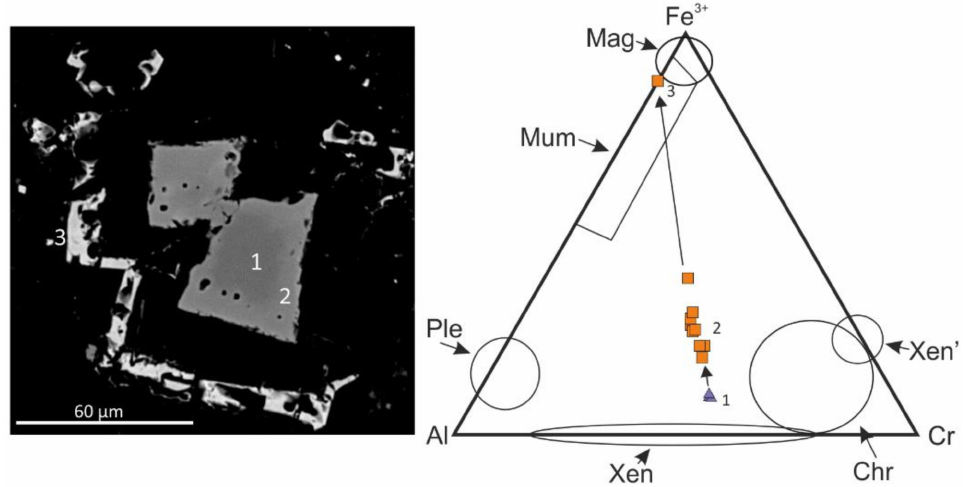
Figure 9. BSE images of crystals and diagrams Al-Fe 3+ -Cr for spinels from Chuktukon damtjernites. In Cr-spinels of damtjernites, the concentration of Cr is (1.011 → 0.622 ph.u.), Al (0.756 → 0.497 ph.u.), Mg (0.714 → 0.516 ph.u.), Fe 3+ (0.250 → 0.600 ph.u.), Ti (0.107 → 0.200 ph.u.), and Fe 2+ (0.292 → 0.603 ph.u.). The Cr/(Cr + Al) ratio varies from 0.55 to